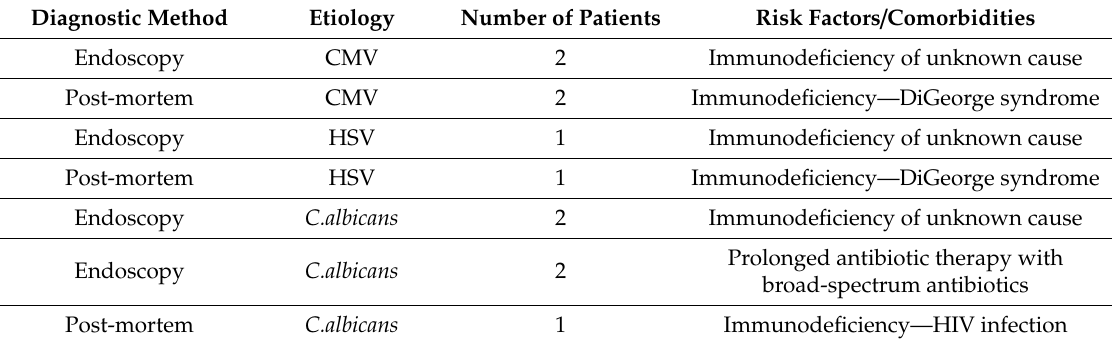
Table 1. Etiology / risk factors /